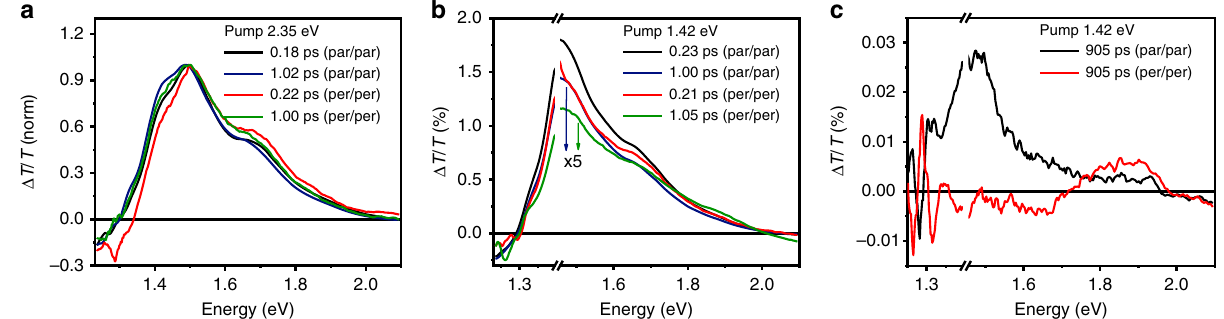
Fig. 2 Polarized transient absorption spectra (TA). Pump/probe light beams polarized either parallel (paral/paral) or perpendicular (perp/perp) to the polymer chain main axis. a TA spectra acquired with a pump wavelength of 2.35 eV at 0.22 and 1 ps. b TA spectra acquired with a pump wavelength of 1.42 eV at ( b ) 0.23 and 1.00 ps; ( c ) 905